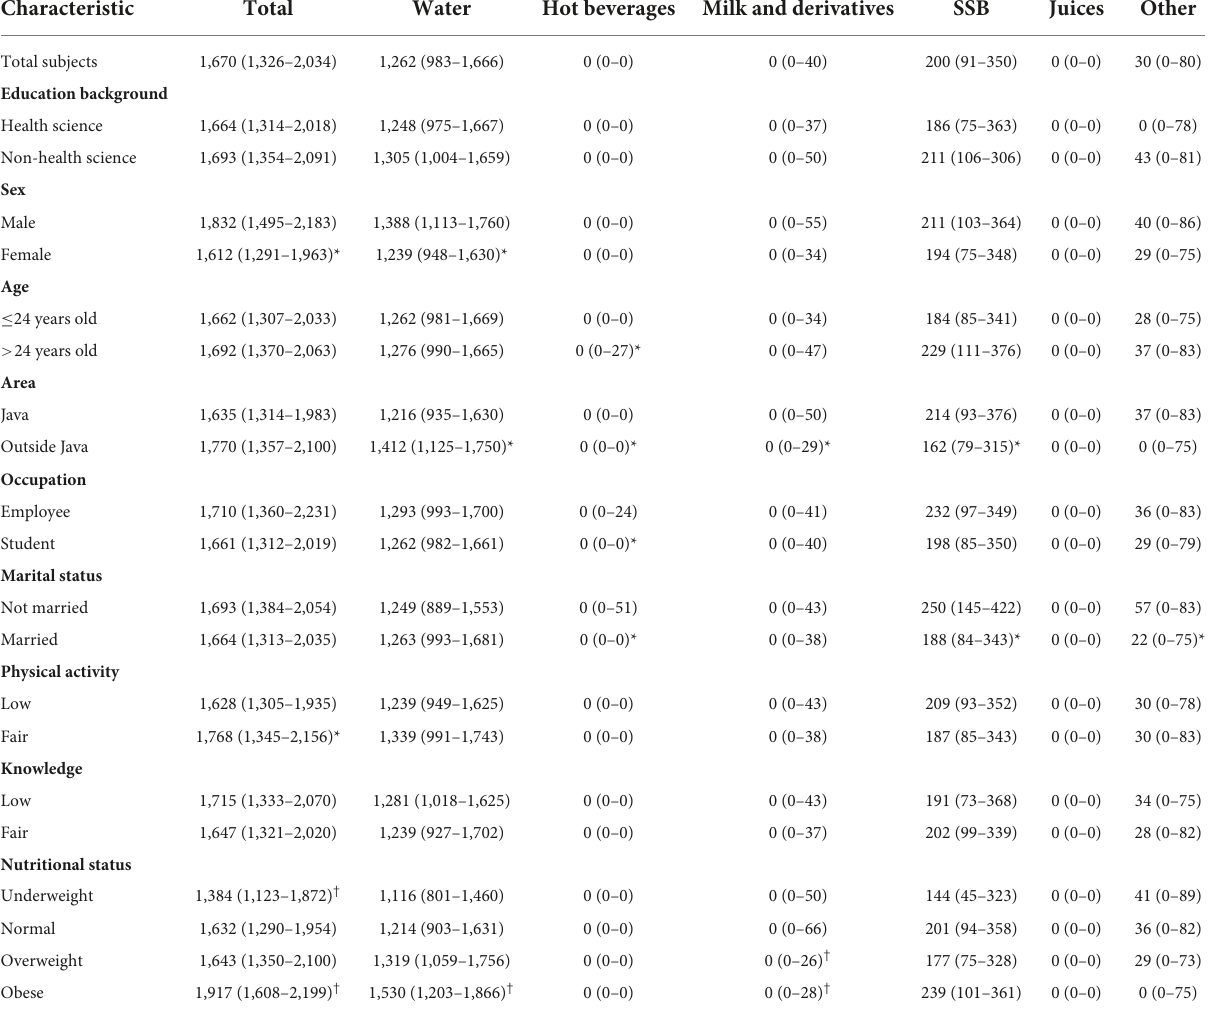
TABLE 2 Fluid intake water and beverages according to subjects’ characteristics of different groups